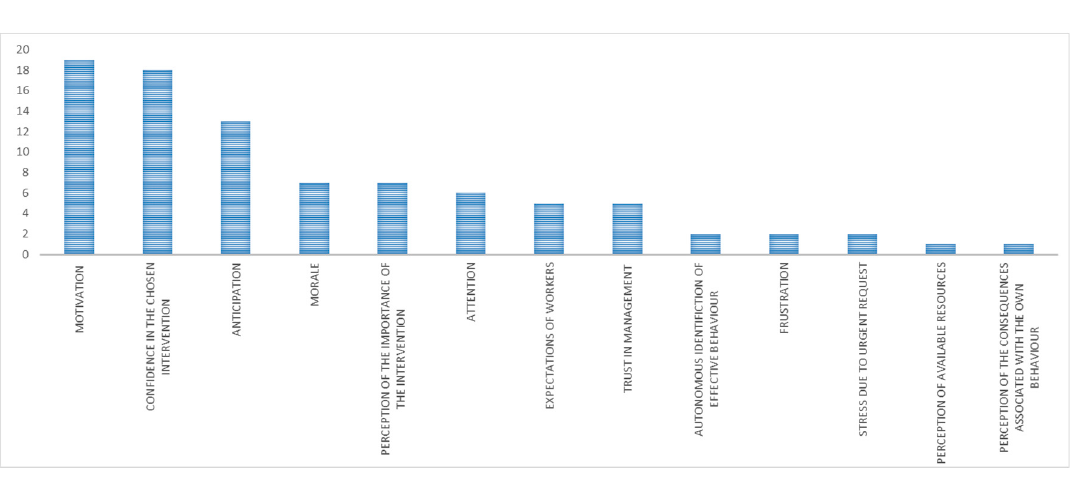
Figure 7. Main mechanisms (in terms of number of occurrences) in technical interventions with expected outcome.